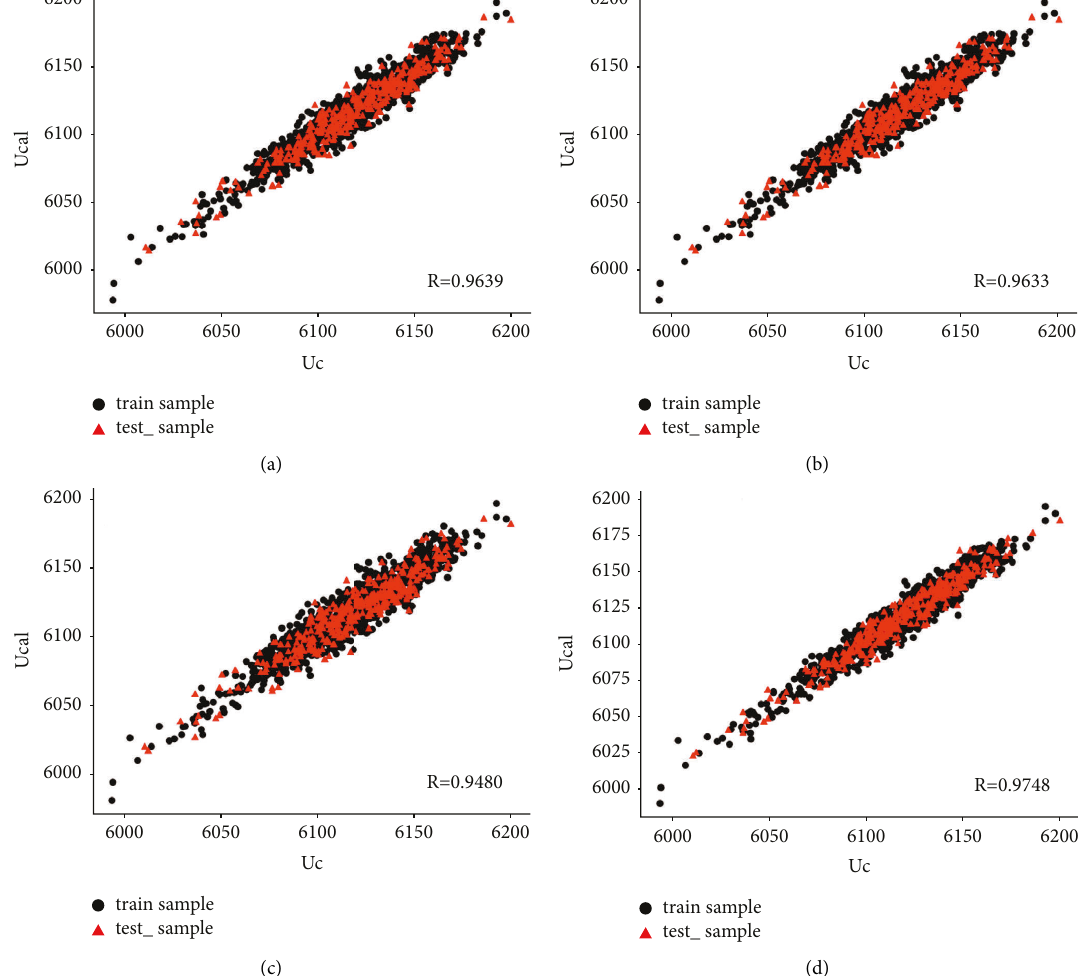
Figure 8: The scatter plot of U U by RS (a), TPE (b), SA (c) , and AGBO (d) with linear c and cal Compared with the learning rate, the values of MAE, RMSE, and MAPE of AGBO only have slight differences and the optimal values of weight decay are 1e-6. The convergence plot of AGBO with the optimal parameters is shown in Figure 10, and the loss value is converged to 0 after ap- proximately 400 iteration steps. Compared with three SMBO algorithms, the convergence curve of AGBO is much smoother and stabler. This result can be attributed to the fact that in the gradient-based optimization method proposed in this work, the searching direction for parameter update is deterministic, while for other gradient-free methods, the searching direction is heuristic and largely dependent on the initialization, which usually leads to an oscillation in the loss function, making the convergence much more difficult.